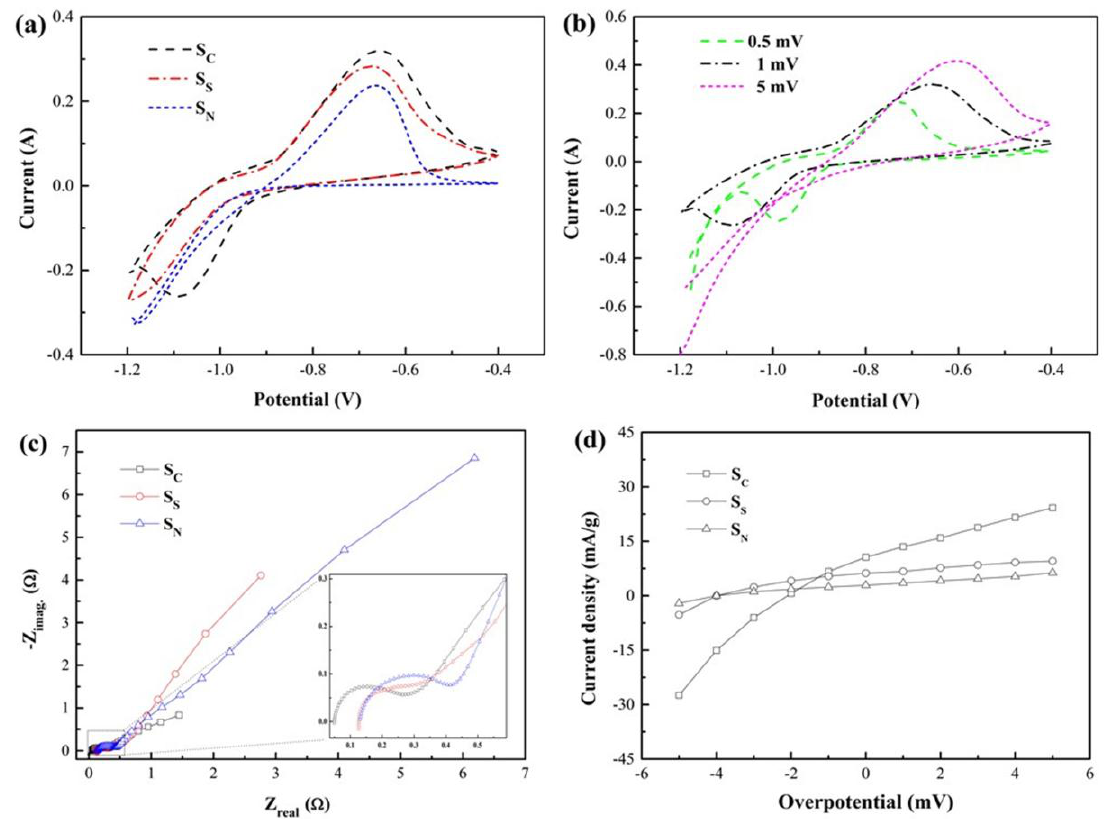
Figure 4. Typical CV curves of Co-B alloys: ( a ) the scanning rate was 1 mV/s; ( b ) the CV curves of the S C at different scanning rates; ( c ) EIS and ( d ) LP of Co-B alloy electrodes at 50% DOD and 298 K.